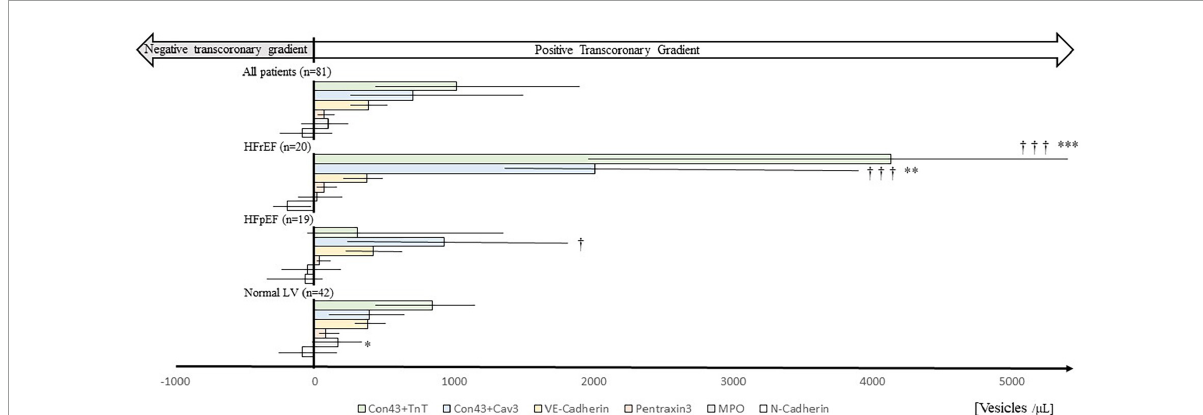
FIGURE1 Trans -coronary gradients of extracellular vesicles in patients presented by heart failure phenotype. Horizontal bars show median trans -coronary concentration gradients of different EV phenotypes in patients with HFrEF, HFpEF, or Normal LV phenotype calculated as plasma concentrations in coronary sinus minus concentrations in radial artery. For comparison all patients ( n = 81), irrespective of HF phenotype, are shown (top of figure). Median values (bars), interquartile ranges (horizontal lines), and p -values (between patient group comparisons; Mann–Whitney U -test) are also shown. ∗ p < 0.05, ∗∗ p < 0.01, ∗∗∗ p < 0.001 compared to HFpEF. † p < 0.05, ††† p < 0.001 compared to Normal. Con43 + TnT: Connexin-43 + Troponin T; Con43 + Cav3: Connexin-43 + Caveolin 3; MPO: Myeloperoxidase. Numerical data are shown in Supplementary